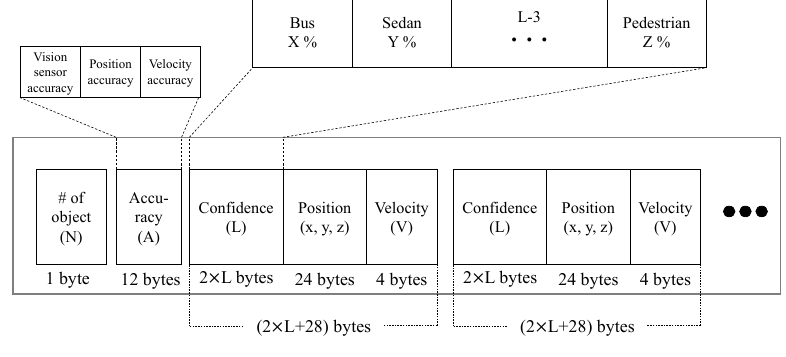
Figure 6. Proposed message